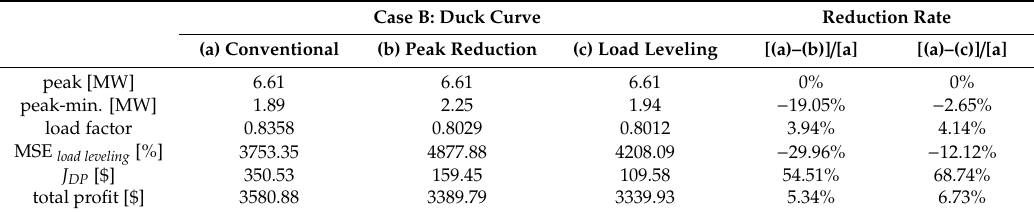
Table 5. Comparison of the data obtained applying the proposed method and conventional method to the duck